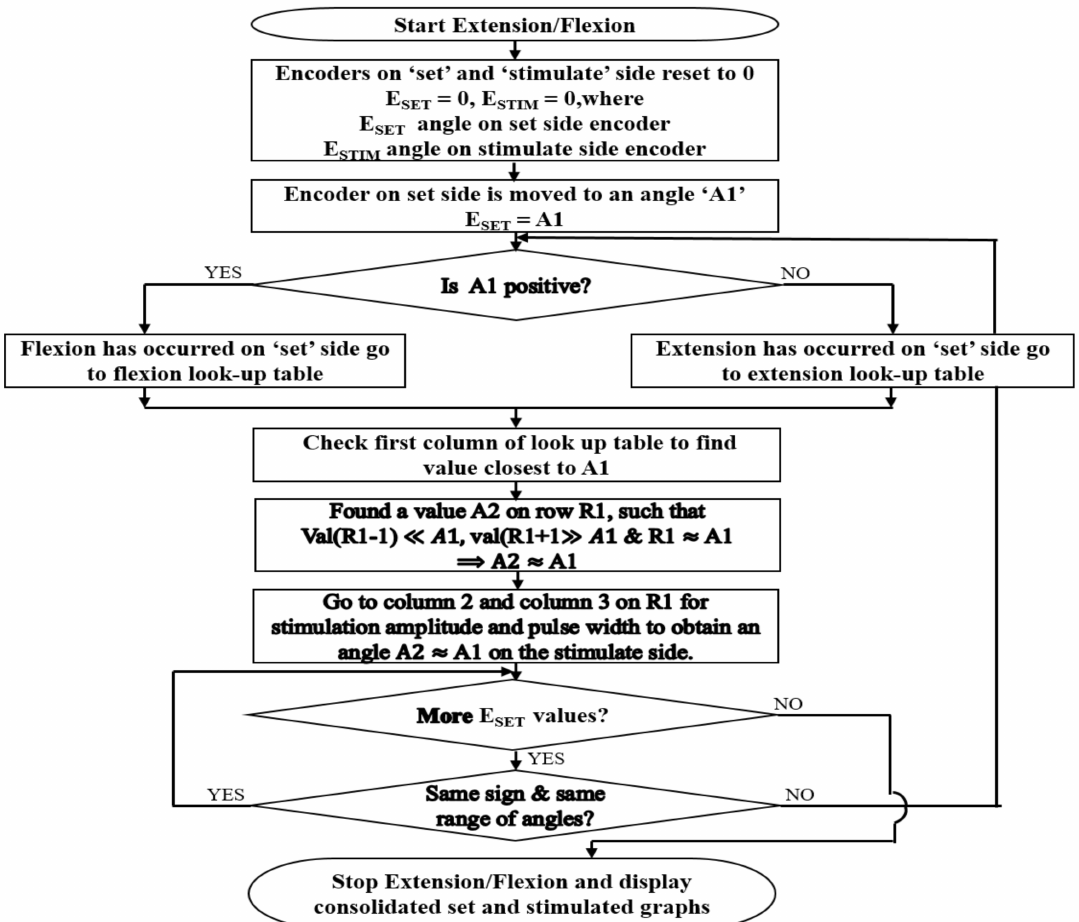
Figure 4. Algorithm followed by the set/stimulate record app. The Flowchart describes how mirroring is performed with the help of the flexion and extension calibration table